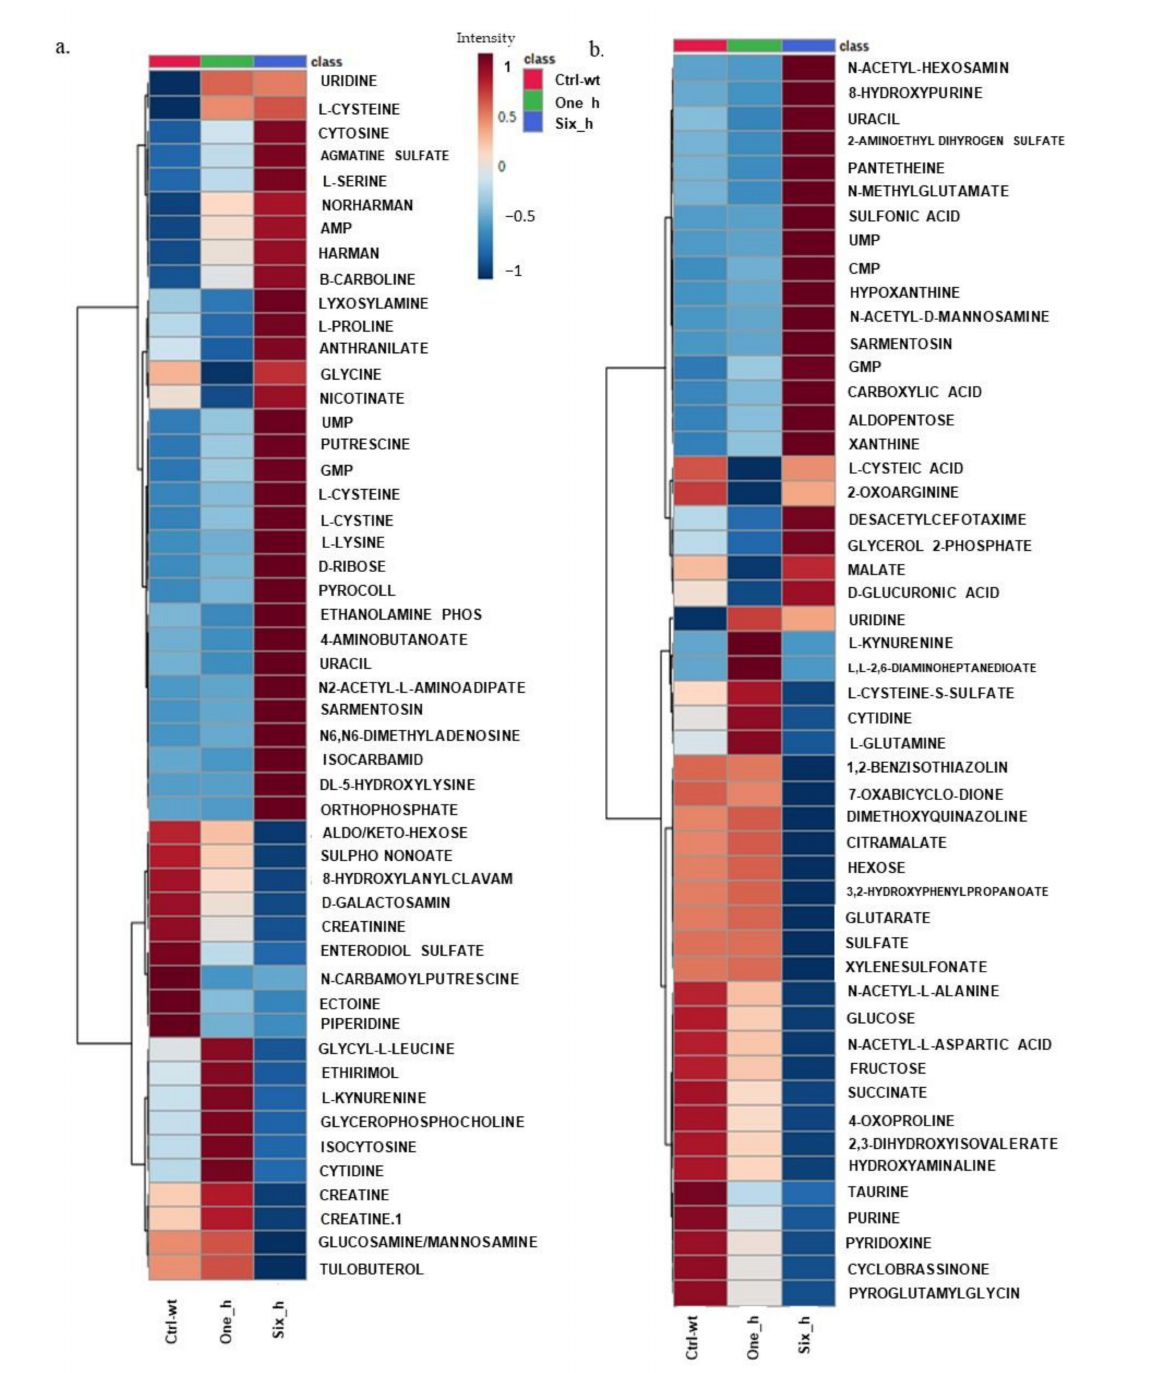
Figure 1. Heatmaps showing the effect of carvacrol on X. perforans . Panels ( a , b ) show hierarchical clustering of changes in metabolites in the time series in response to carvacrol treatment for the top 50 metabolites. Treatments include untreated wild type (ctrl-wt), samples at 1 h after treatment with carvacrol (One_h), and samples at 6 h after treatment with carvacrol (Six_h). Each treatment was replicated four times. A pooled sample from all four replicates for each treatment was included as a fifth replicate. The average intensities for the five replicates in each treatment are shown. The side bar represents the graduation in intensities, with 1 and − 1 representing the highest and lowest intensity or concentration of metabolites, respectively, in both panels. See Supplementary Figure S3xi,xii for changes in all annotated metabolites in response to carvacrol